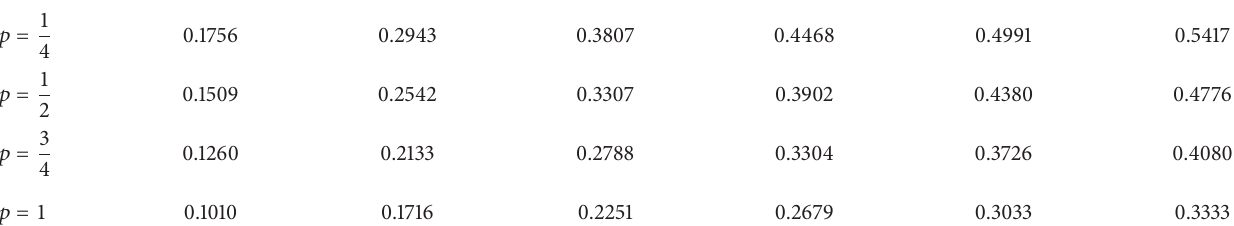
Table 1: Bounds comparison on different values of 𝑝